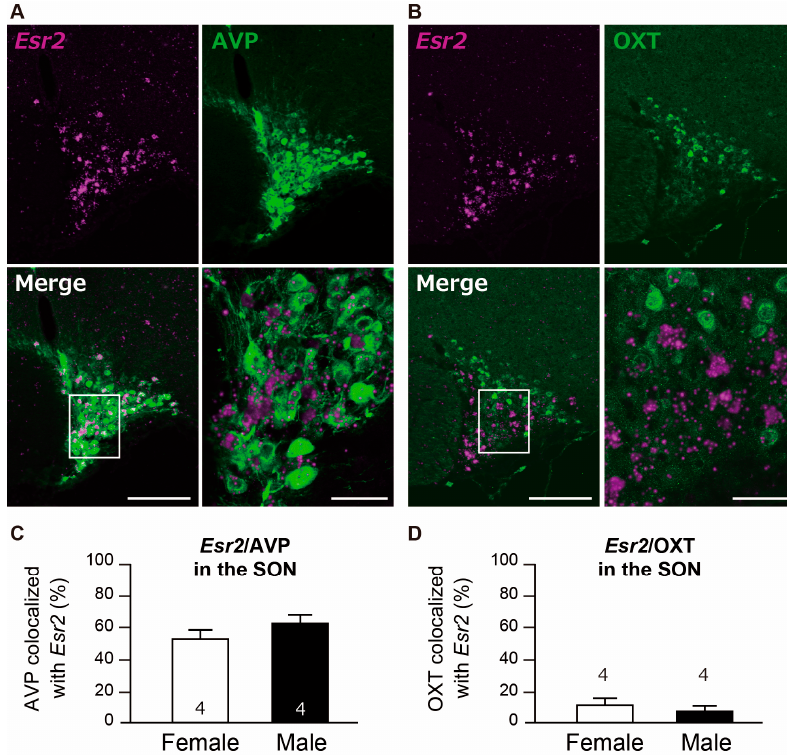
Figure 5. Co-expression of Esr2 / arginine vasopressin (AVP) and Esr2 / oxytocin (OXT) in the supraoptic nucleus (SON). Representative photomicrographs show dual labeling of Esr2 mRNA (magenta) and AVP (green) in the SON of female rats ( A ), and dual labeling of Esr2 mRNA (magenta) and OXT (green) in the SON of female rats ( B ). High magnification images (the bottom right images) correspond to the boxed areas in the overviews in A and B. Scale bar measures 50 µ m for high magnifications and 200 µ m for low magnification images in A and B. The bar graph shows the co-expression percentage of Esr2 mRNA / AVP-ir cells in the SON ( C ) and Esr2 mRNA / OXT-ir cells in the SON ( D ). Values represent the mean ± SEM. The number in each column indicates the number of animals used.